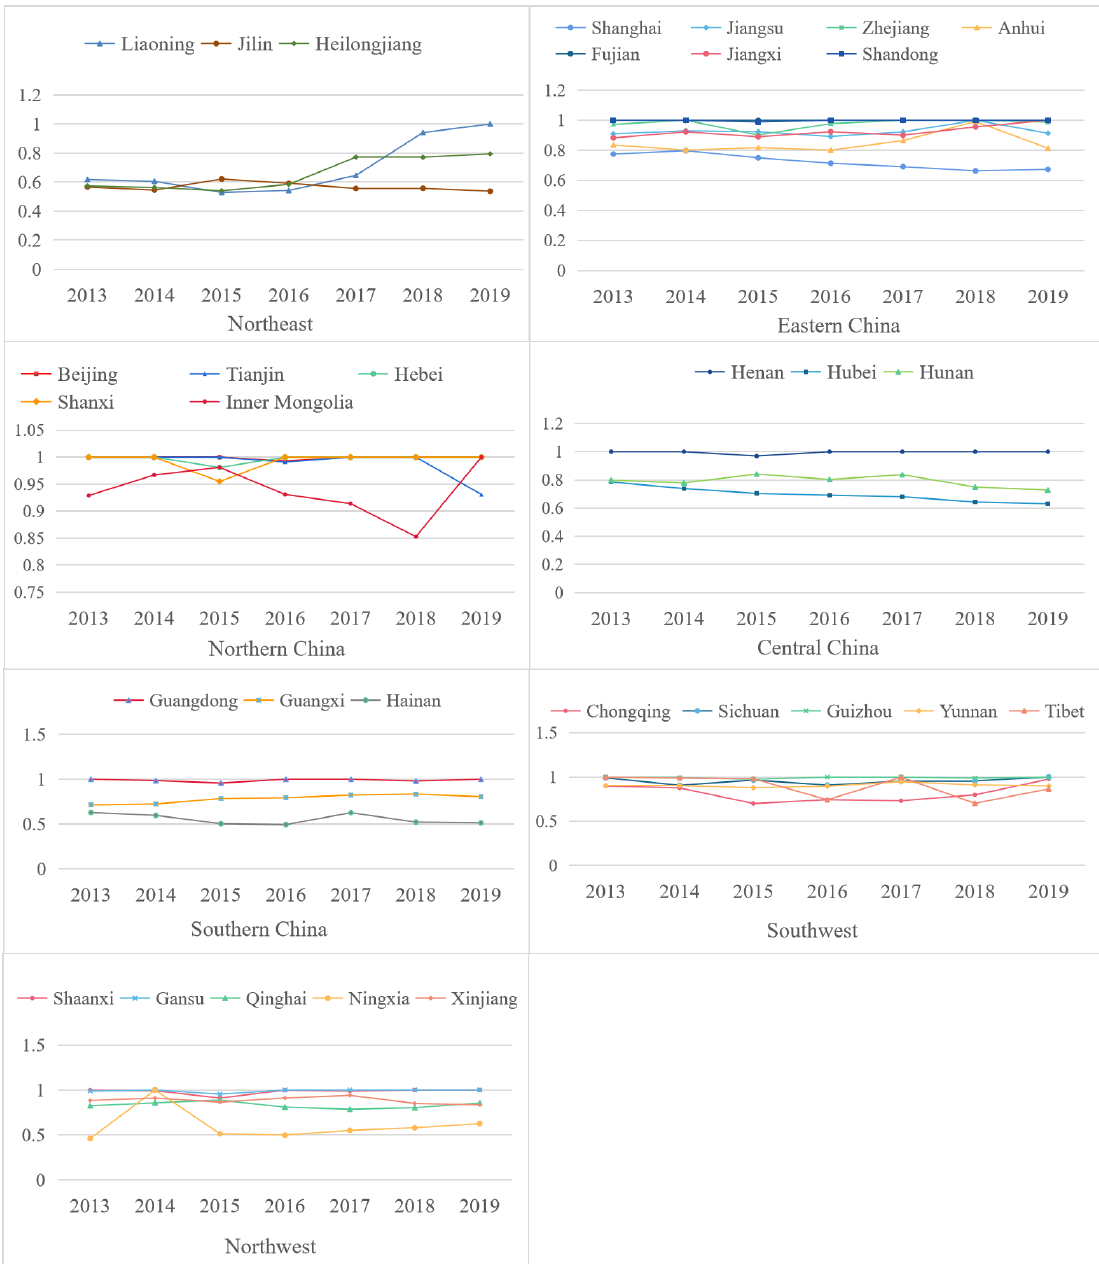
Figure 2. WRM performance index of 31 provinces in China from 2013 to 2019 based on Window DEA model.